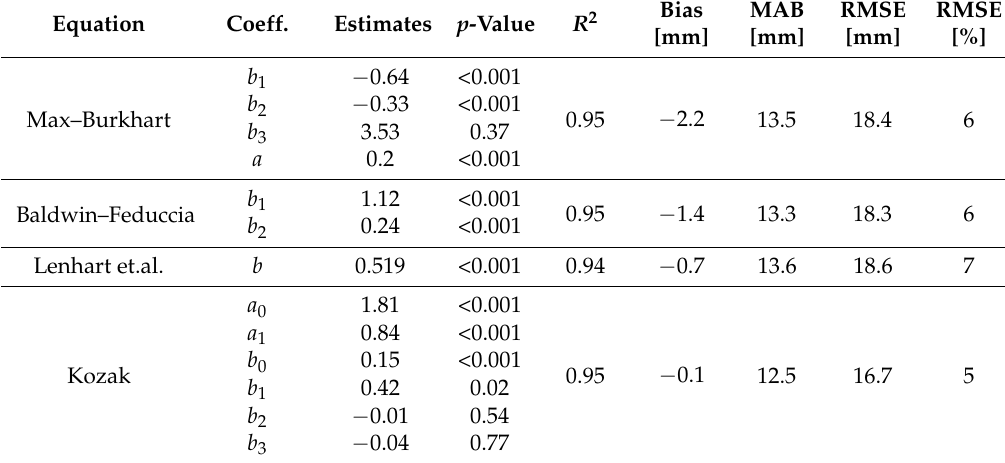
Table 6. Taper models developed from the bias corrected PPC-based measurements. Equation